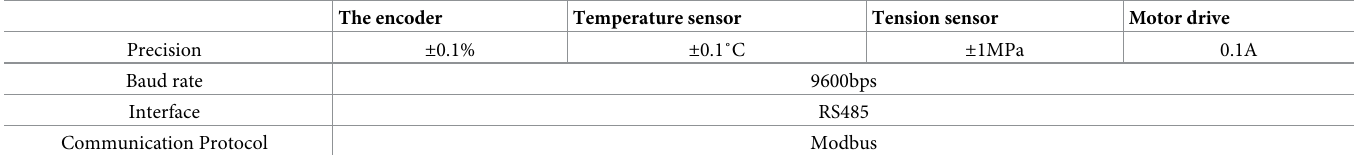
Table 5. The parameters of sensor